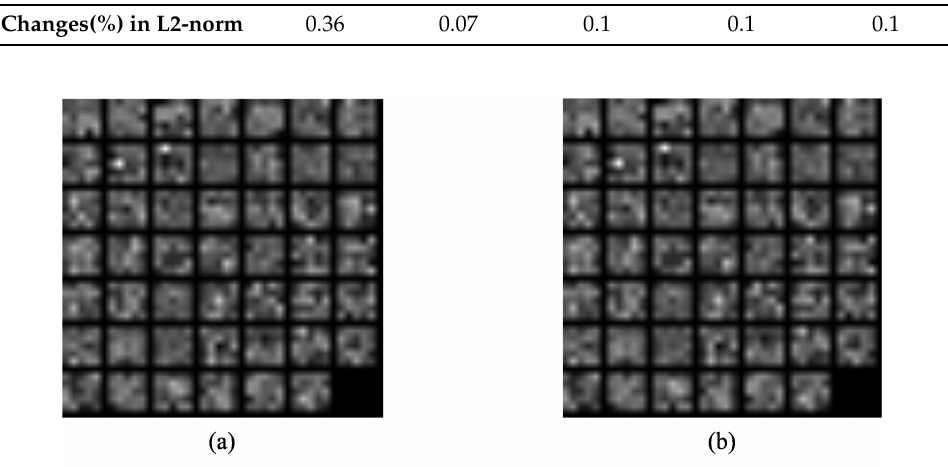
Figure 8. The 1st convolutional layer kernels of baseline and transfer learning method. ( a ) baseline; ( b ) transfer learning method.